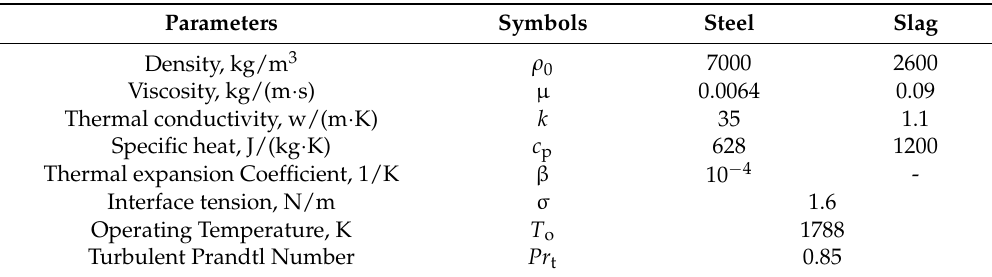
Table 1. Thermal properties of the steel and